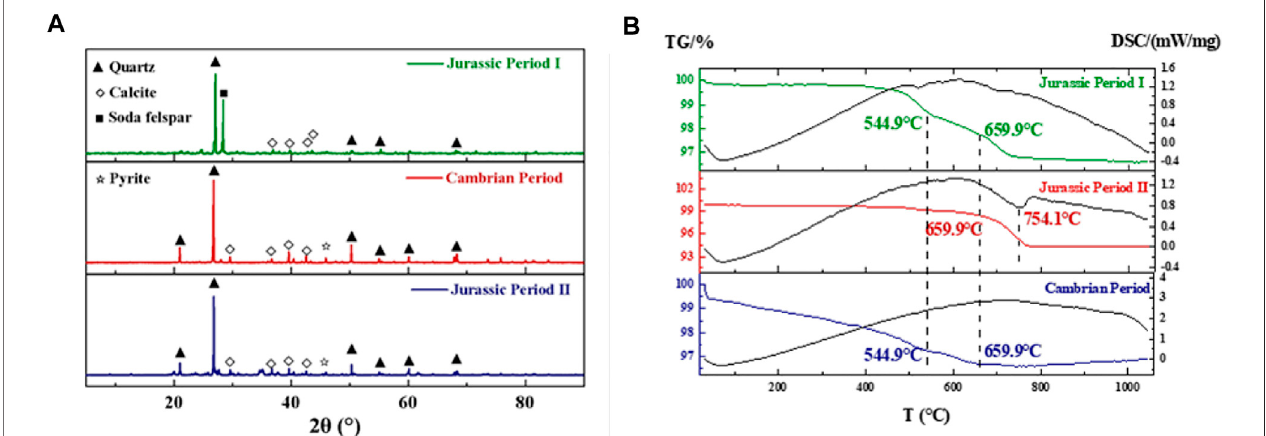
FIGURE 3 | (A) XRD θ -2 θ scan of rocks (B) Thermogravimetric curve of rocks.